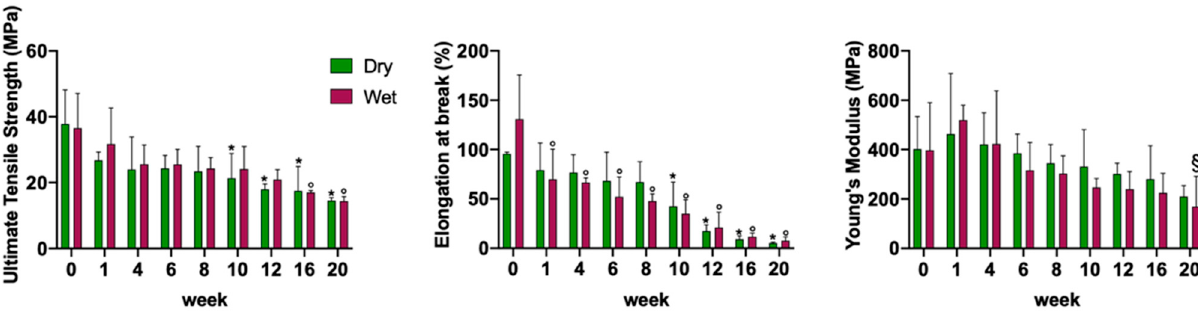
Figure 8. Mechanical properties of electrospun PLGA scaffolds in dry and wet conditions in PBS at different degradation time points. * statistically significant between non ‐ degraded (week 0) and degraded PLGA scaffolds under dry conditions ( p < 0.05). ° statistically significant between non ‐ degraded (week 0) and degraded PLGA scaffolds under wet conditions ( p < 0.05). § statistically significant between PLGA scaffolds degraded at week 1 and week 20 under wet conditions ( p < 0.05).